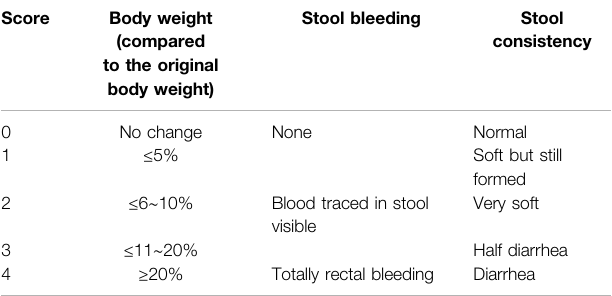
TABLE 1 | Criteria for scoring disease activity index